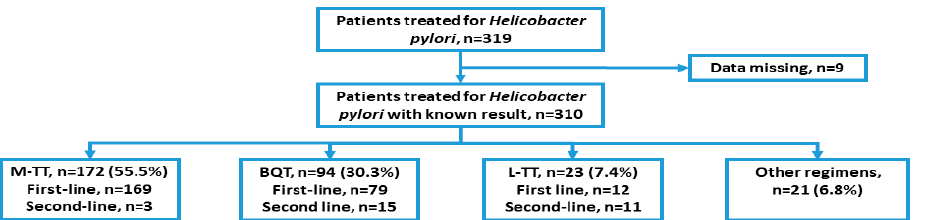
Figure 1. Flow chart of the overall study design and treatment regimens for the first-line and second-line therapy. M-TT—metronidazole-based triple therapy, BQT—bismuth quadruple therapy, L-TT—levofloxacin-based triple therapy. Table 1. Baseline characteristic, diagnostic, and treatment methods of patients included in the